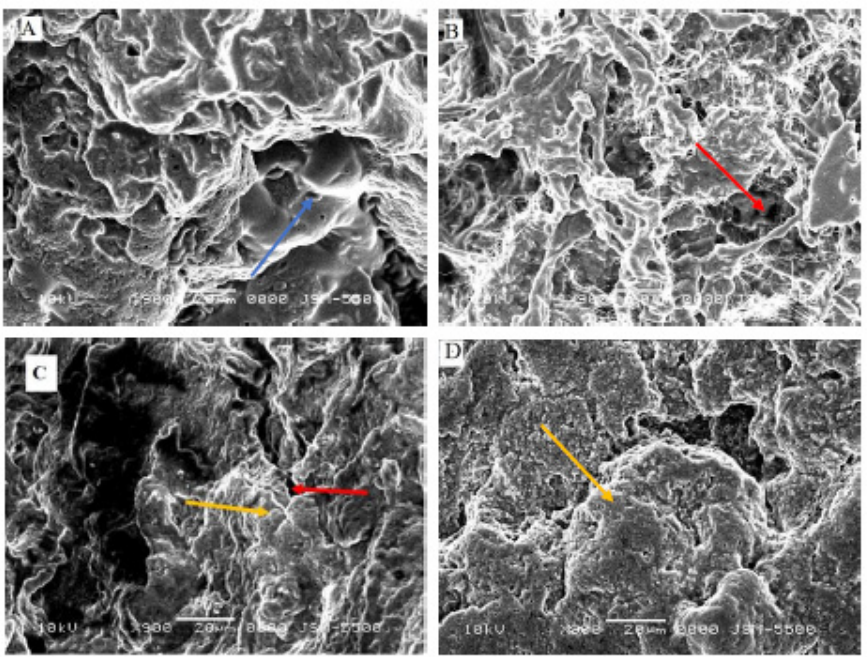
Figure 6. The SEM images of set yogurts produced from homogenized and non-homogenized raw milk and processed milk combined with 4% Lacprodan ® PL20. ( A ) Non-homogenized raw milk (NRM control sample). ( B ) Non-homogenized processed milk (NPM). ( C ) Homogenized raw milk (HRM). ( D ): Homogenized processed milk (HPM). The red, yellow, and blue arrows indicate the holes, surface interactions, and MFGM fragments, respectively. The scale bar is 20 µm.